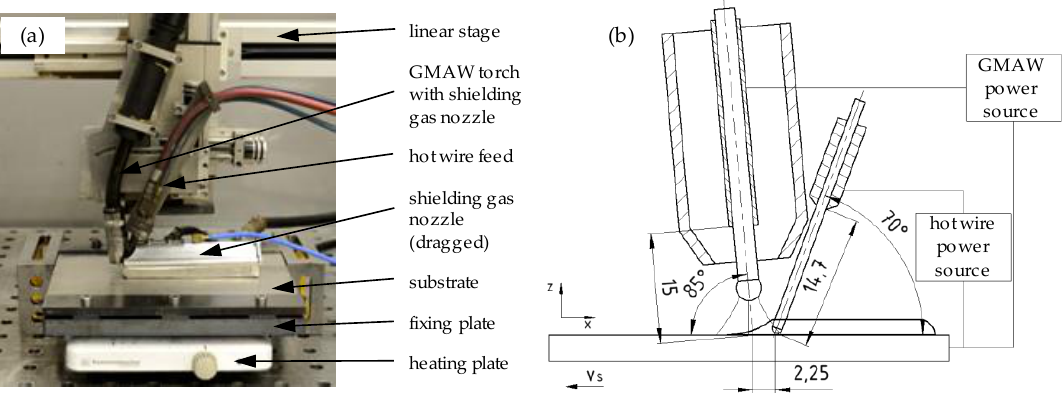
Figure 1. ( a ) Experimental setup of the gas metal arc welding process (GMAW) with additional hot-wire process and ( b ) schematic depiction of the GMAW process with additional hot wire process with geometric parameters.